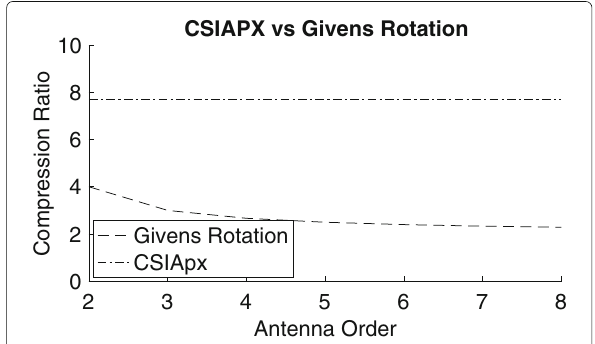
Fig. 15 Compression ratio comparison with Givens rotation. The comparison between compression ratio for CSIAPx versus Givens Rotation is shown for the experimental